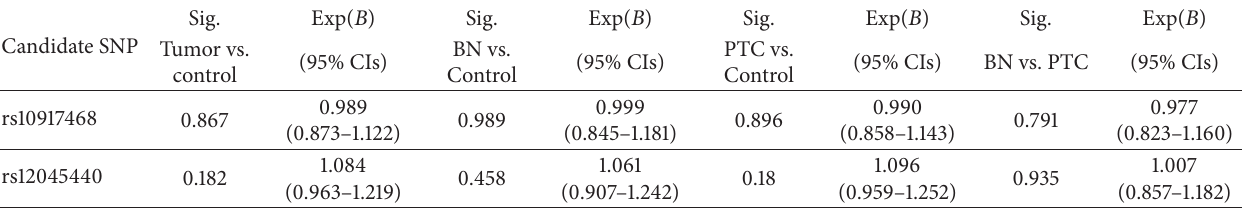
Table 2: Associations between the SNPs within the CAPZB gene and risk of thyroid